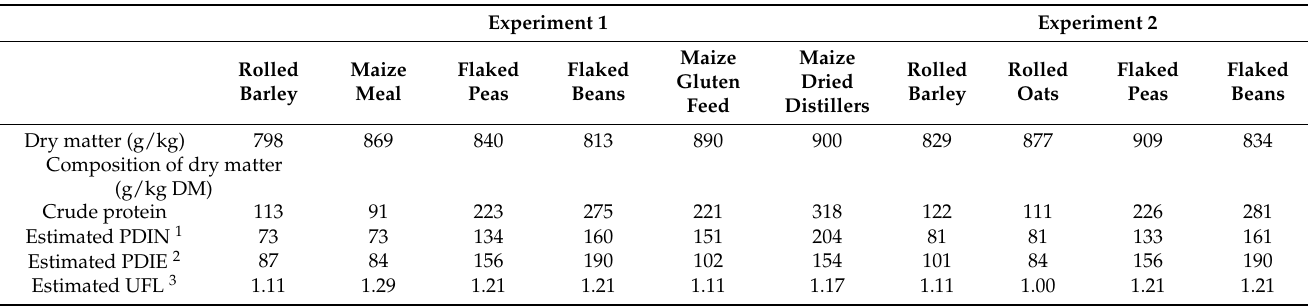
Table 1. Dry matter, chemical composition and in vitro digestibility of the individual primary feed ingredient used in Experiments 1 and